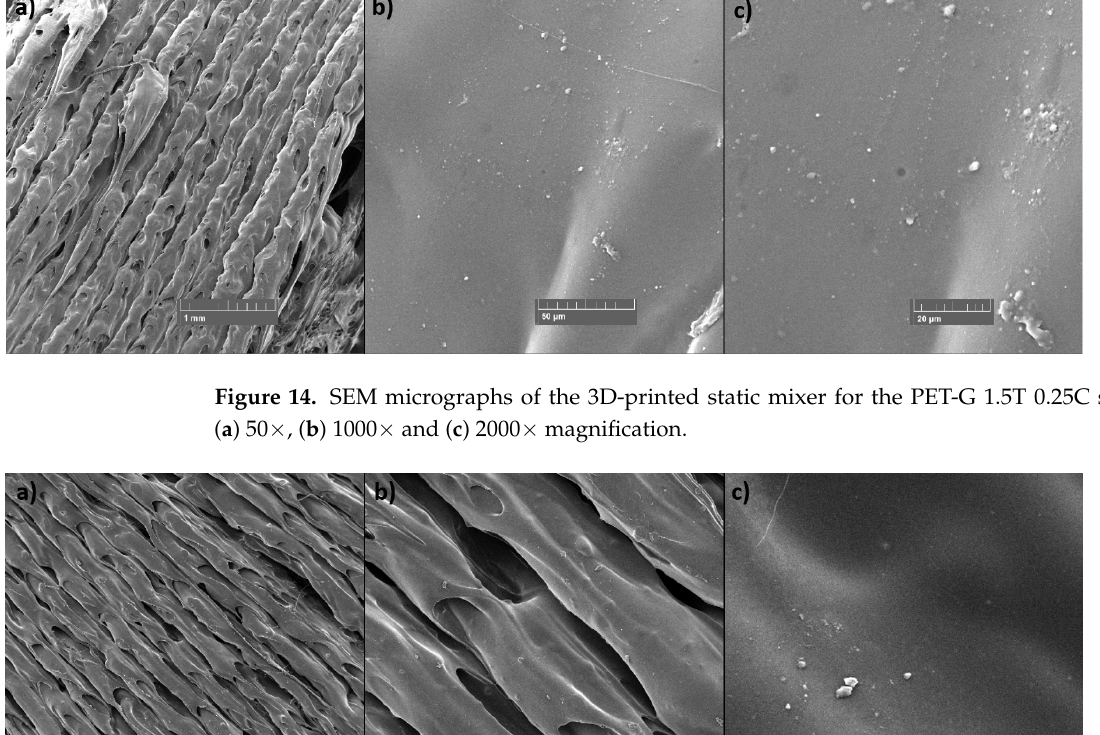
Figure 16. SEM micrograph of the 3D-printed static mixer from pure PET-G at 50× magnification . 3.7. 3D Printing All of the prepared composites were successfully used for 3D printing. Some of the printed static mixers are shown in Figures 17 and 18. In Figure 17, on the bottom static mixer 3D printed from the composite material, imperfections on the surface can be observed. Those imperfections are formed because of the clogging of the nozzle and/or unequal flow of the material due to the previously mentioned inhomogeneity of the composite materials. Additionally, imperfections on the surface can occur as unwanted marks after support structure removal. The surface containing said imperfections in this specific case can have a positive impact because of the specific-surface-area increase.